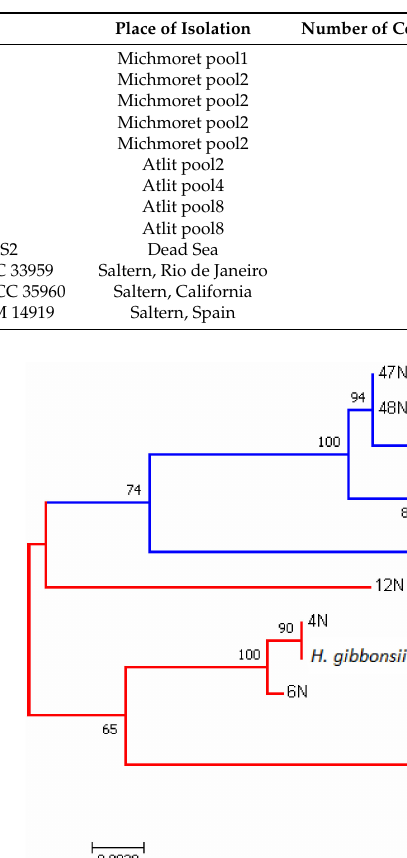
rpoB1 results (Table S1), with 4N and 6N showing higher sequence similarity to H. gibbonsi than did isolates 10N, 16N and 19N and 12N, which corresponded to a more distant lineage. In contrast to the rpoB1 phylogeny, 24N appears to be closely related to H. volcanii , yet shares higher average nucleotide identity to H. lucentense . Table 1. List of Haloferax isolates collected from four pools from two rocky shores along Israel’s Mediterranean coastline (Atlit and Michmoret) and related Haloferax species added to the analysis due to their similarities to the isolates. * Total length includes all replicons.